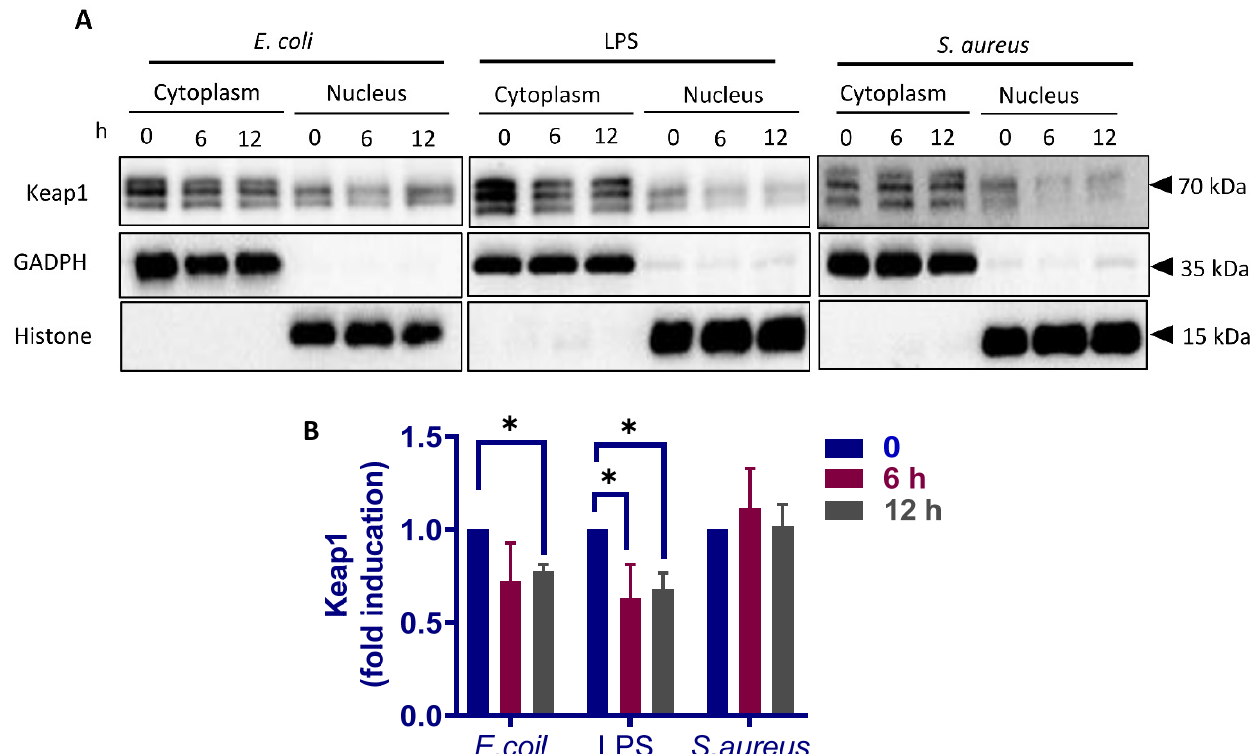
Figure 9. E. coli and S. aureus differentially regulate Keap1 degradation. ( A ) Cytoplasmic and nuclear proteins were extracted from cells treated with E. coli (1 × 10 7 particles/mL), S. aureus (1 × 10 7 particles/mL) and lipopolysaccharides (LPS) (10 µ g/mL) and were analyzed by immunoblotting with anti-Keap1. GADPH and Histone are shown as loading controls, respectively. ( B ) A chart bar shows Keap1 levels determined with densitometry analyses after normalization to GADPH. Data are representative of three triplicates and are representative of 3 separate experiments. * p < 0.05.